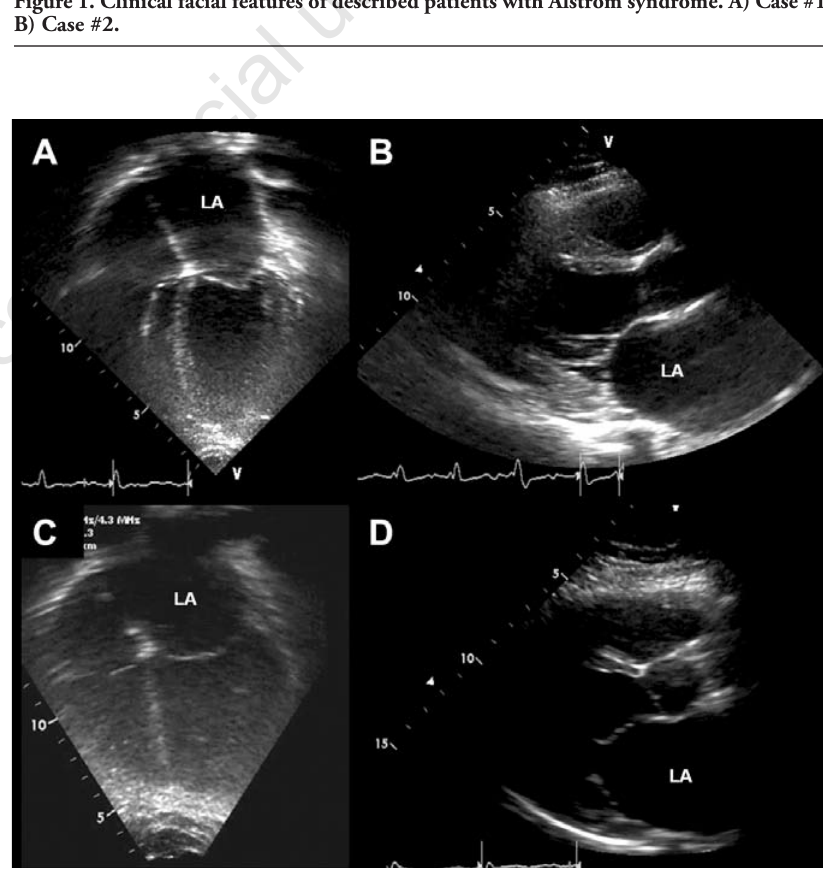
Figure 2. Patient phenotype and echocardiogram. A) Four chamber view of Case #1. Note the dilated cardiac phenotype as well as the dilated left atrium; B) Long axis view of